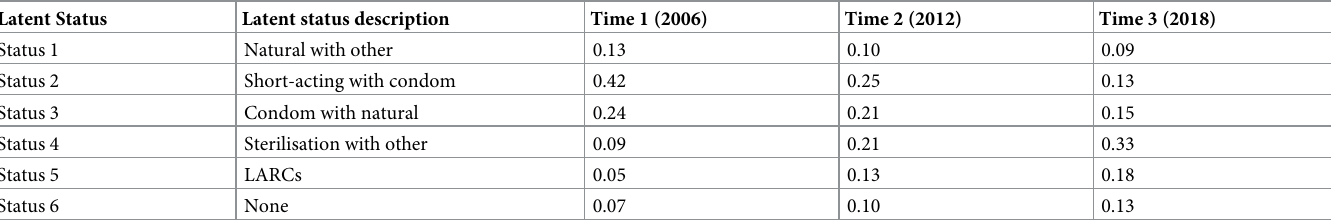
Table 3. Latent status membership probabilities (delta estimates) for six-status model.